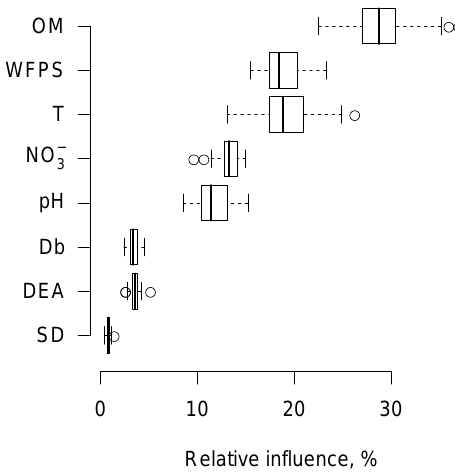
Fig. 2. Boxplots (description of quartiles with maximum at 1.5 interquartile range) of relative influences of the 8 tested input variables, as revealed by the BRT8(OM,pH,Db,DEA,SD)G model. Circles are outlier